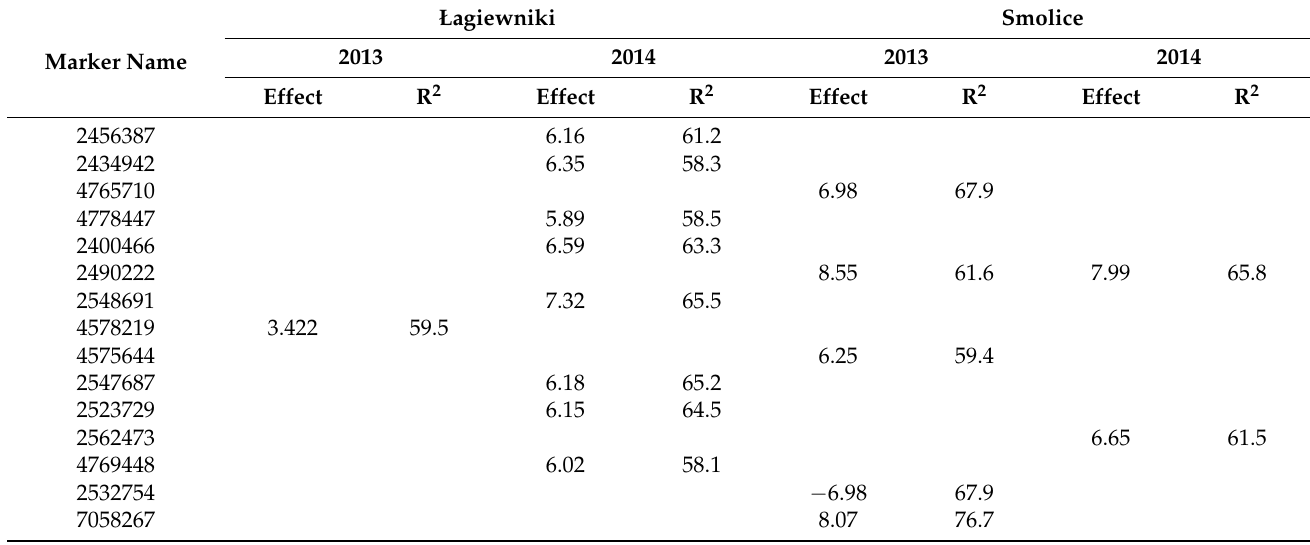
Table 6. Molecular markers (SilicoDArT) significantly (LOD > 3.0) associated with the heterosis effect of the number of grains in a row